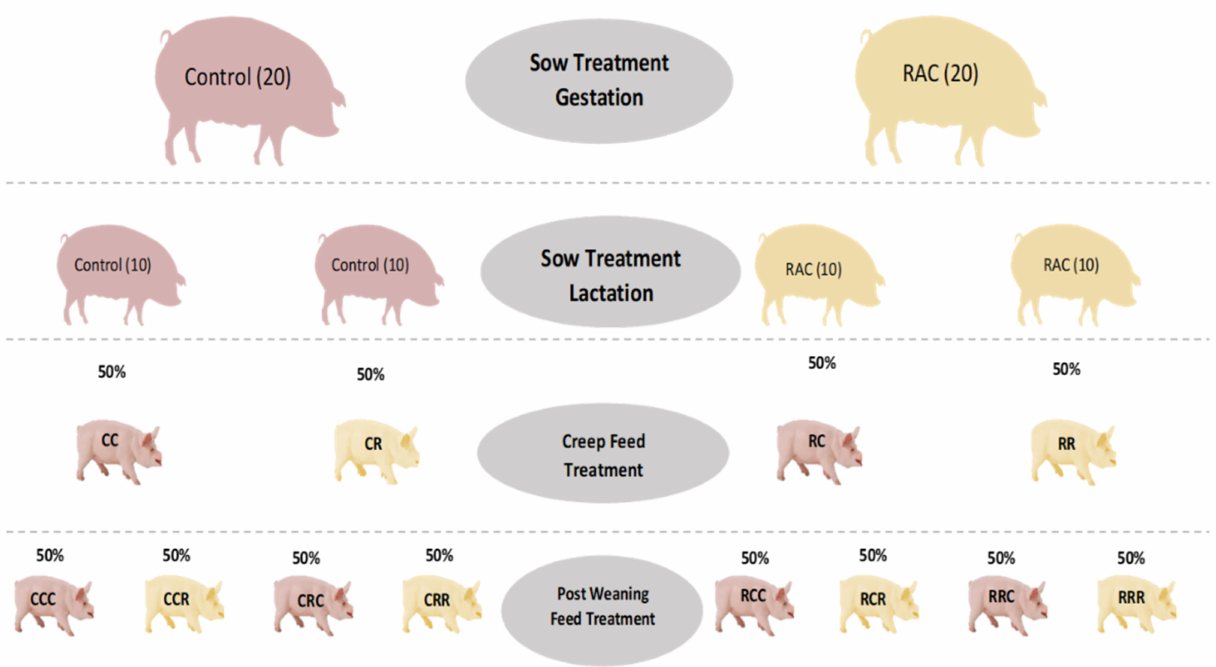
Figure 1. Schematic diagram of sow and piglet feeding plan. RAC = resin acid-enriched composition; RR = sow RAC feeding piglets, RAC creep feeding: RC = sow RAC feeding piglets, control creep feeding: CR = sow control feeding piglets, RAC creep feeding: and CC = sow control feeding piglets, control creep feeding. RRR = sow RAC feeding-piglets RAC creep feeding-piglets post-weaning RAC feeding: RRC = sow RAC feeding-piglets RAC creep feeding-piglets post-weaning control feeding: RCR = sow RAC feeding-piglets control creep feeding-piglets post-weaning RAC feeding: RCC = sow RAC feeding-piglets control creep feeding-piglets post-weaning control feeding: CRR = sow control feeding-piglets RAC creep feeding-piglets post-weaning RAC feeding: CRC = sow control feeding-piglets RAC creep feeding-piglets post- weaning control feeding: CCR = sow control feeding-piglets control creep feeding-piglets post-weaning RAC feeding: and CCC = sow control feeding-piglets control creep feeding-piglets post-weaning control